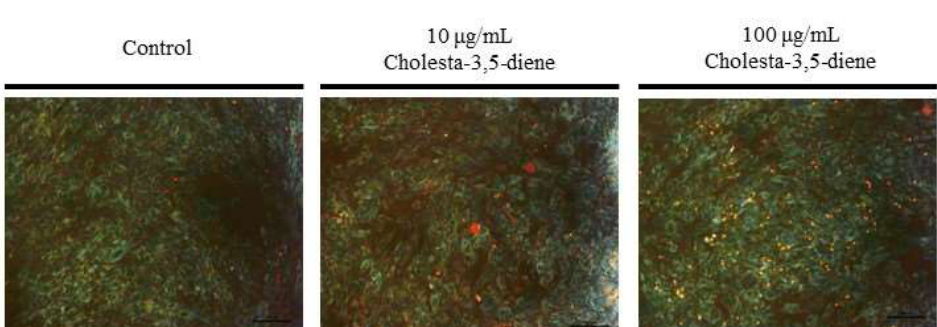
Figure 3. ( a ) Relative cell cytotoxicity and ( b ) image of cytotoxic effects in human oral keratinocytes (HOK).